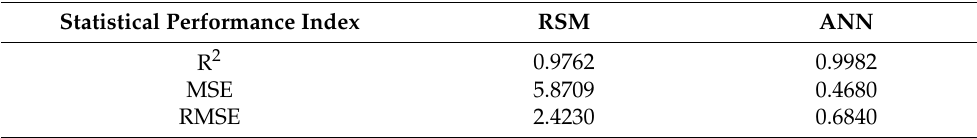
Table 7. Comparison of response surface methodology and artificial neural networks models based on statistical performance